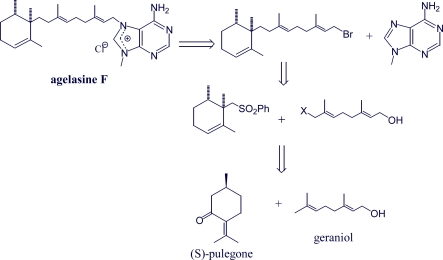
Retrosynthetic analysis of agelasine F [82].